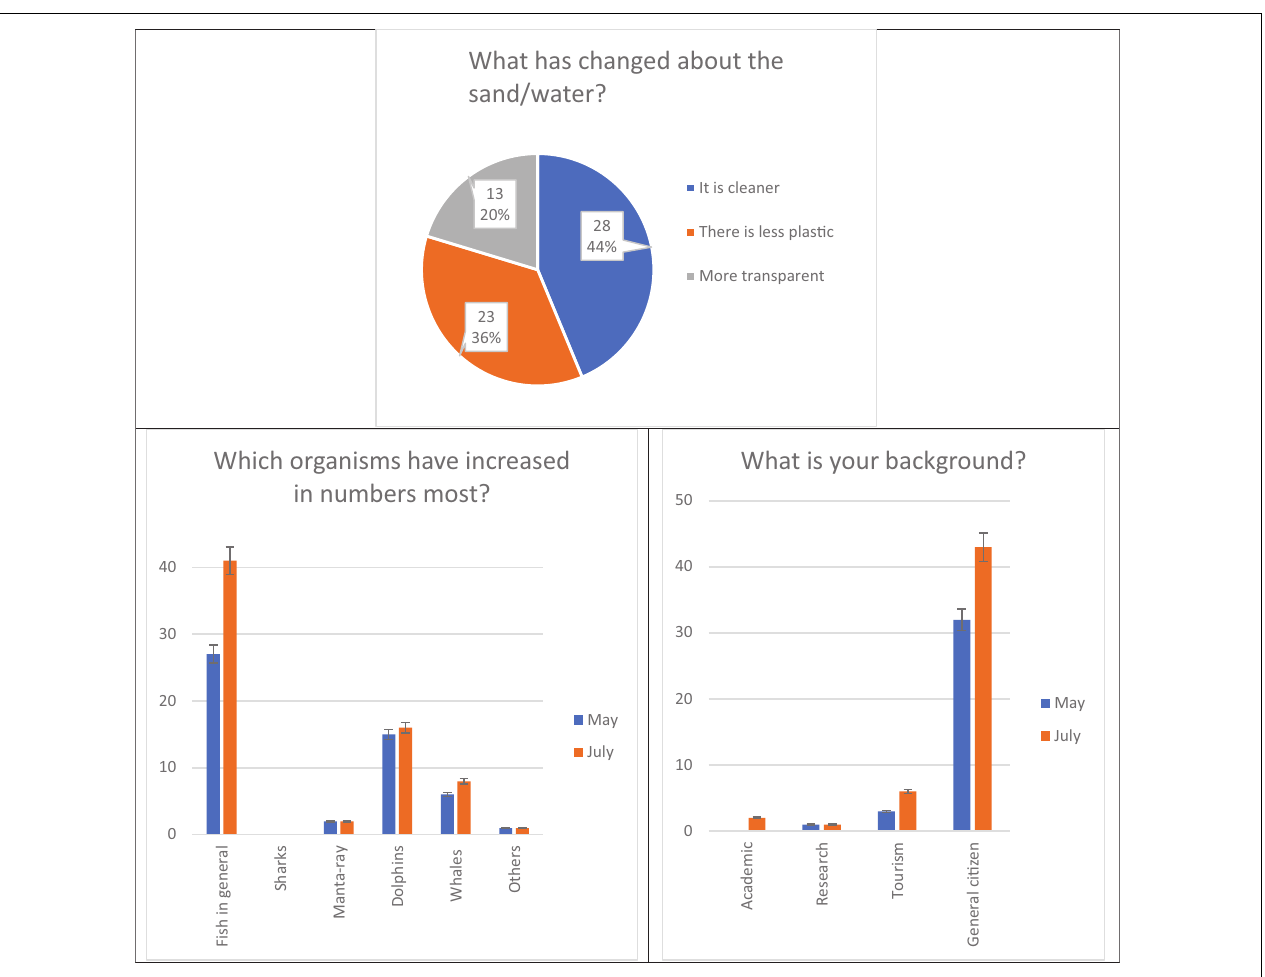
FIGURE 3 | Results from